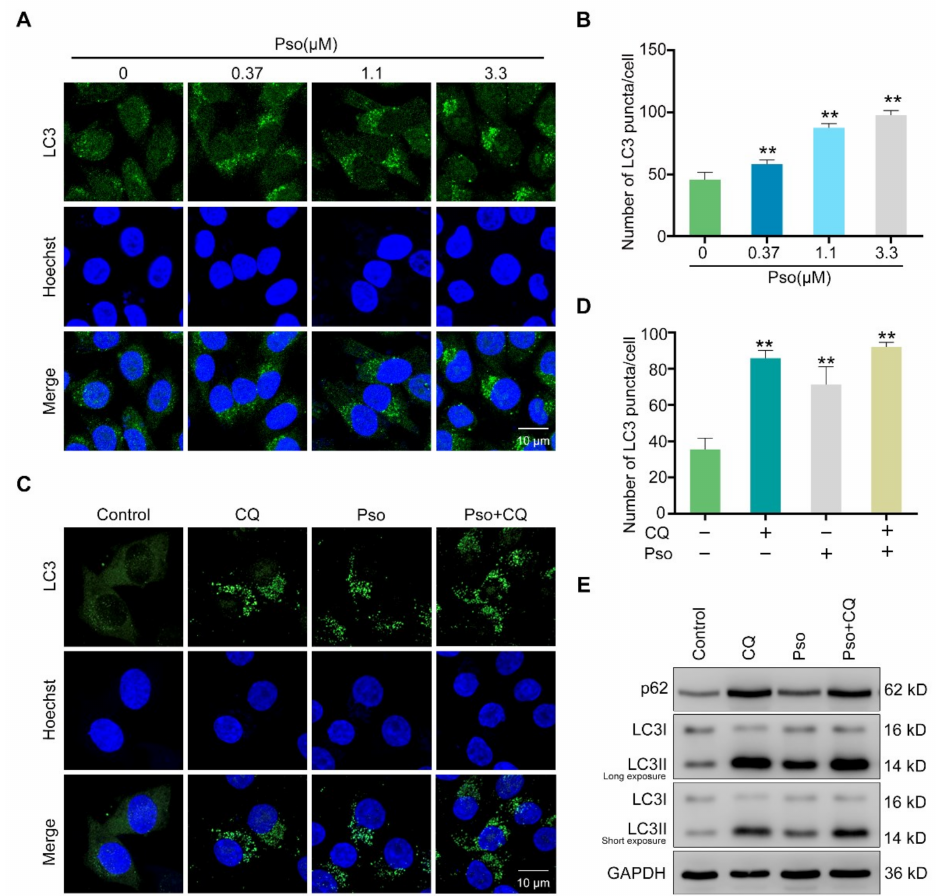
Figure 4. Psoralen promotes the autophagic flux. ( A ) L02 cells were induced with sodium oleate (100 µ M) for 24 h and treated with psoralen at 0.37, 1.1, 3.3 µ M for 24 h. The expression of endogenous LC3 was measured by immunofluorescence and observed by confocal microscopy (scale bar = 10 µ m). ( B ) Quantification of LC3 puncta per cell. ( C ) L02 cells were induced with sodium oleate (100 µ M) for 24 h and then treated with psoralen (3.3 µ M) alone or in combination with CQ (10 µ M) for 24 h. Endogenous LC3 were visualized by immunofluorescence and images captured by confocal microscopy (scale bar = 10 µ m). ( D ) Quantification of LC3 puncta per cell. ( E ) The expression of p62, LC3I, and LC3II was measured by Western blotting. All values were expressed as the mean ± SD from three independent experiments. ** p < 0.01 vs. sodium oleate-induced group. Abbreviations: CQ, chloroquine; Pso,